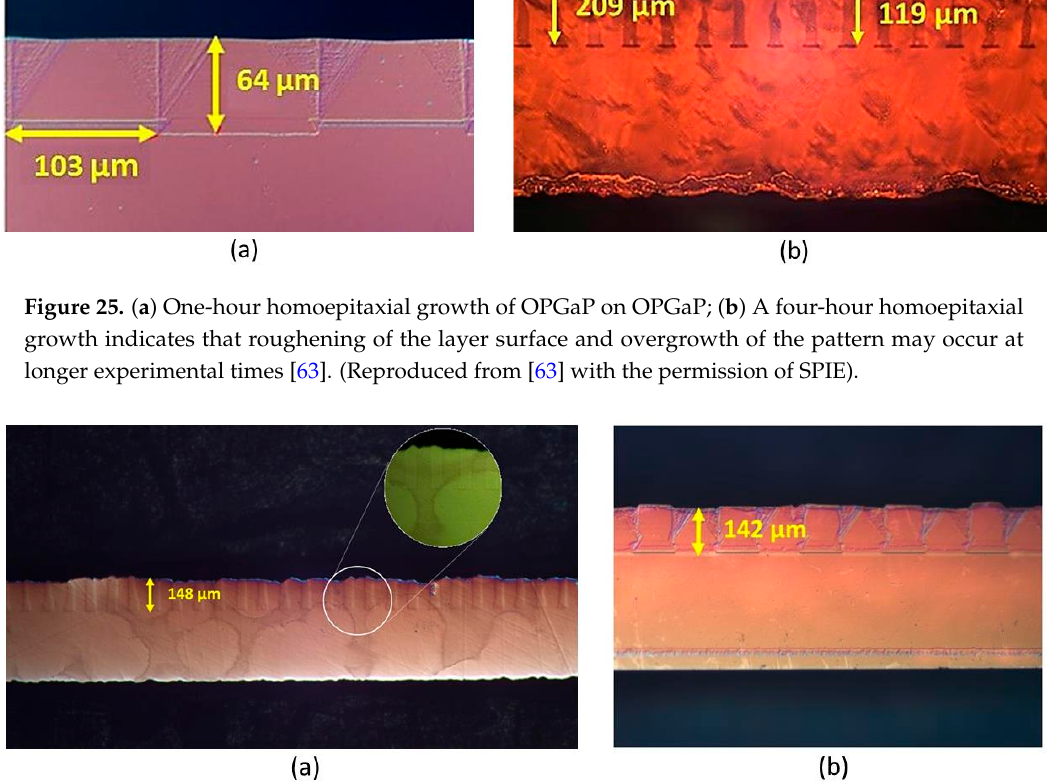
Figure 26. ( a , b ) State-of-the-art experiments limit the good domain propagation to up to 150 µm thick OPGaP layer homoepitaxially grown on OPGaP templates [69]. (Reproduced from [69] with the permission of SPIE).